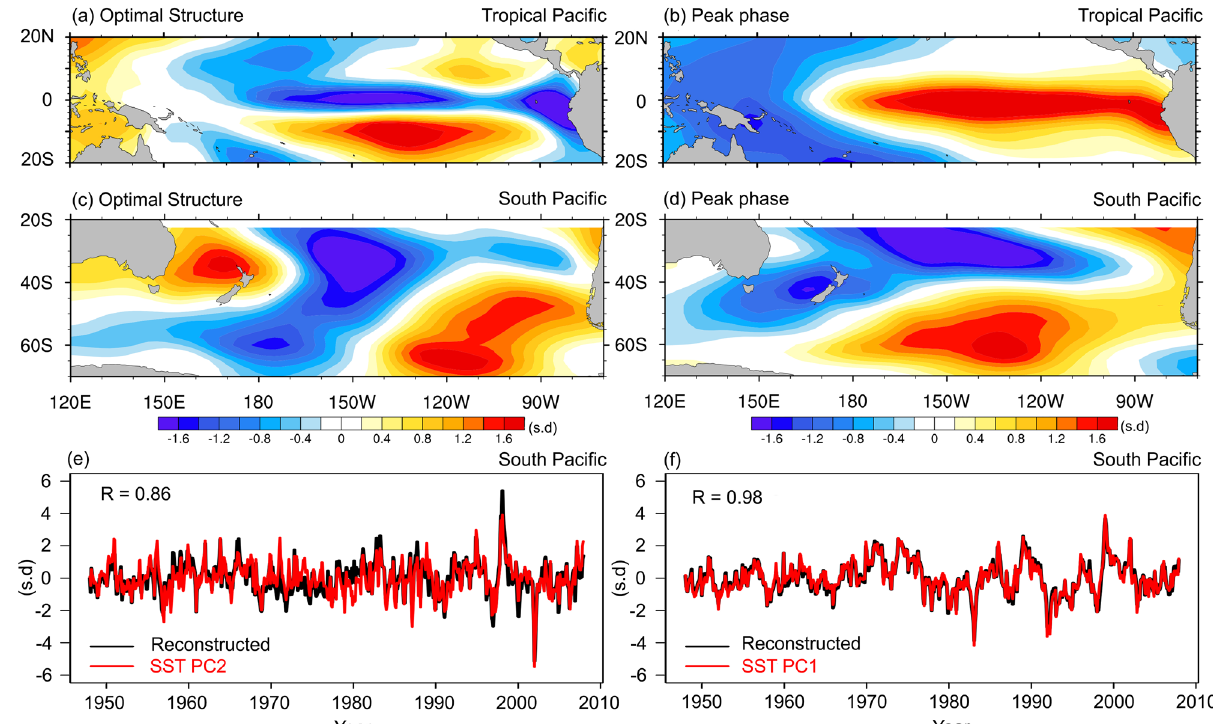
Fig. 3 The optimal evolution of the tropical and South Paci fi c SST. The optimal initial structures in the a tropical Paci fi c and c South Paci fi c are obtained using a linear inverse model (see the text for details), which linearly co-evolve over 9 months into their peak phases in the b tropical Paci fi c and d South Paci fi c. The spatial patterns shown in ( a – d ) are normalised according to the variance in each domain. The reconstructed time series of the e optimal initial structure and f peak phase in the South Paci fi c (black) are compared with the time series of the leading two South Paci fi c SST modes